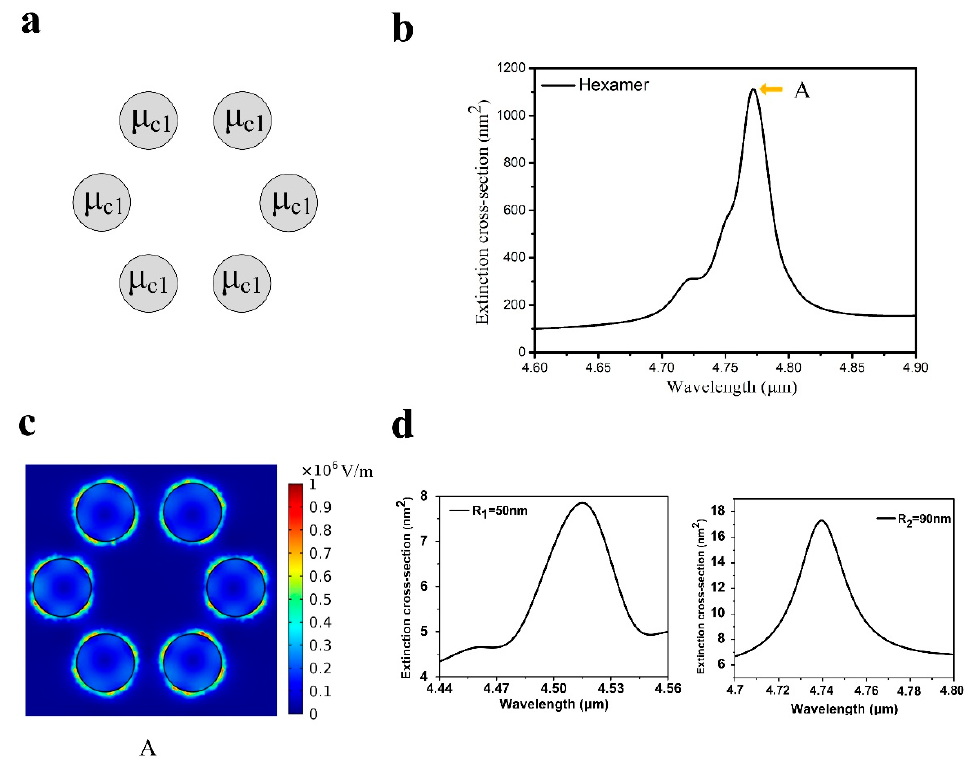
Figure 2. ( a ) There are only six graphene nanodisks with same chemical potential ( 𝜇 (cid:3030)(cid:2869) ) on satellite orbits. ( b ) A pronounced peak in the extinction spectrum of the graphene hexamer appears when the incident plane light wavelength ranges from 4.6 µ m to 4.9 µ m. ( c ) The electric field ( | E | ) distribution of A. ( d ) The calculated extinction spectrum of a single nanodisk in the ring (left panel). Simultaneously, the central nanodisk is also considered (right panel).